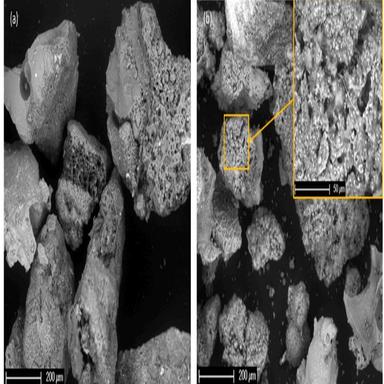
Morphology of as-received MSWI BA (0–2 mm) detected by SEM (100 and 500×magnification, with an accelerating voltage of 10 kV).